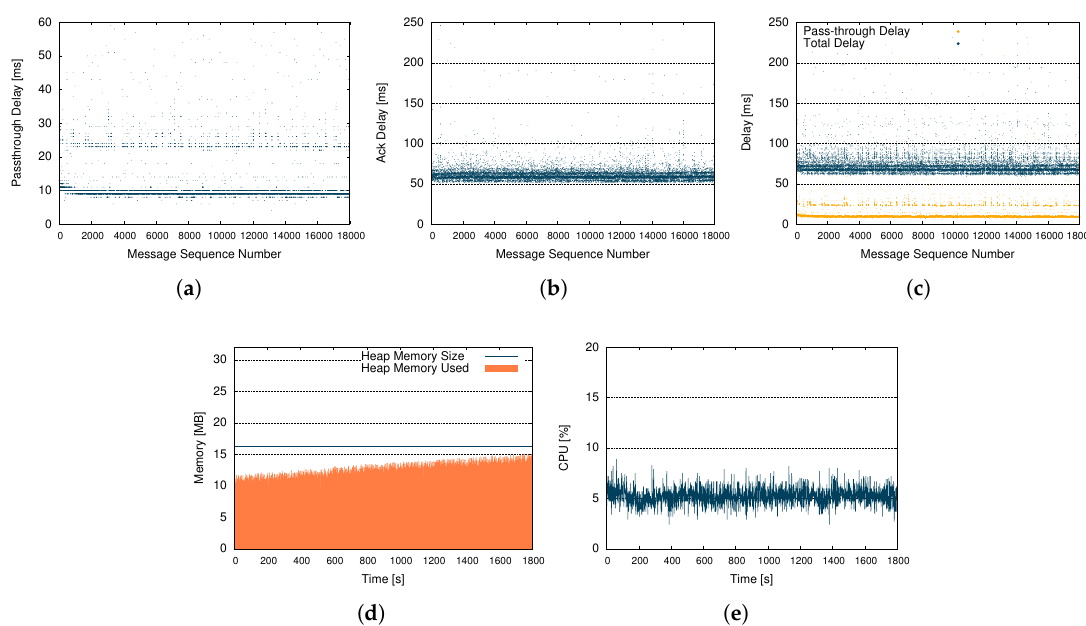
Figure 12. Raspberry Pi experimental results: ( a ) telemetry messages pass-through delays; ( b ) telemetry messages ack delays; ( c ) combined view of telemetry messages delays; ( d ) memory usage with the -Xmx16m option; ( e ) CPU